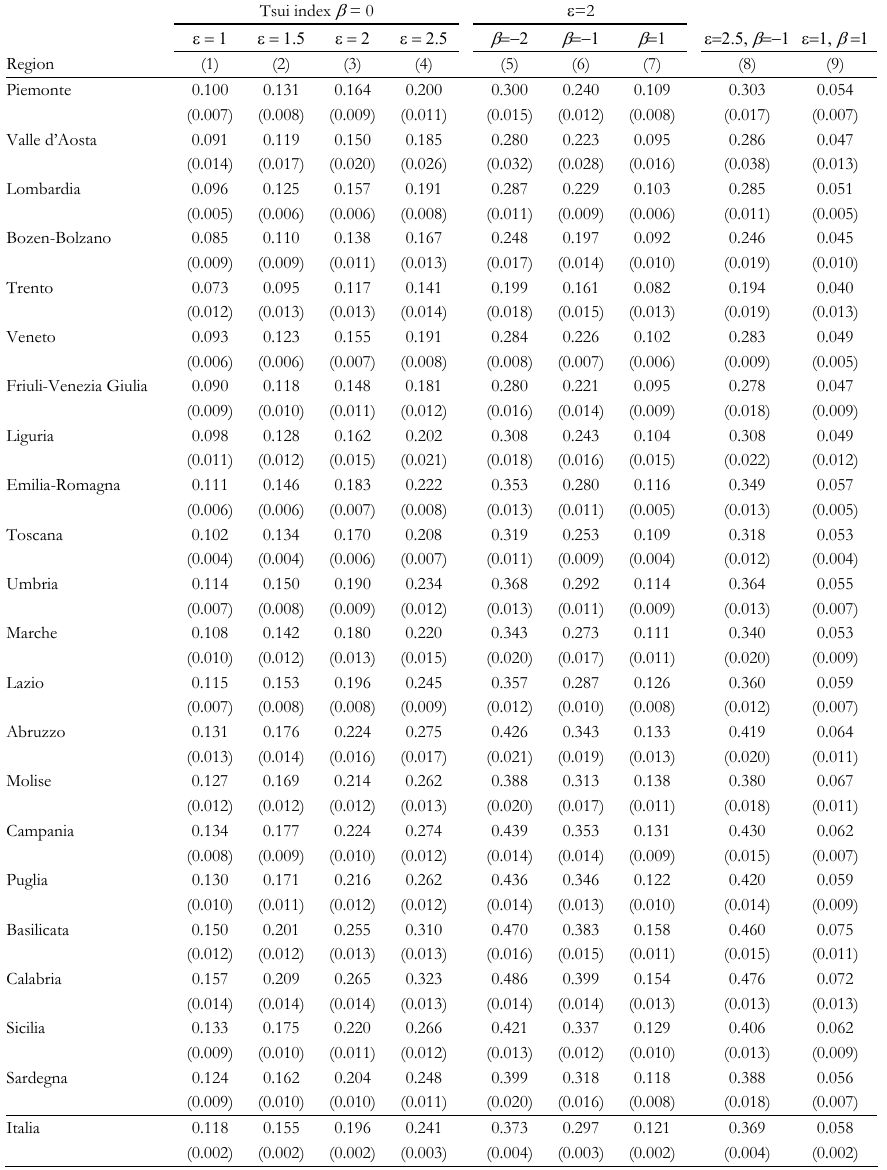
Regional multidimensional inequality measures (year